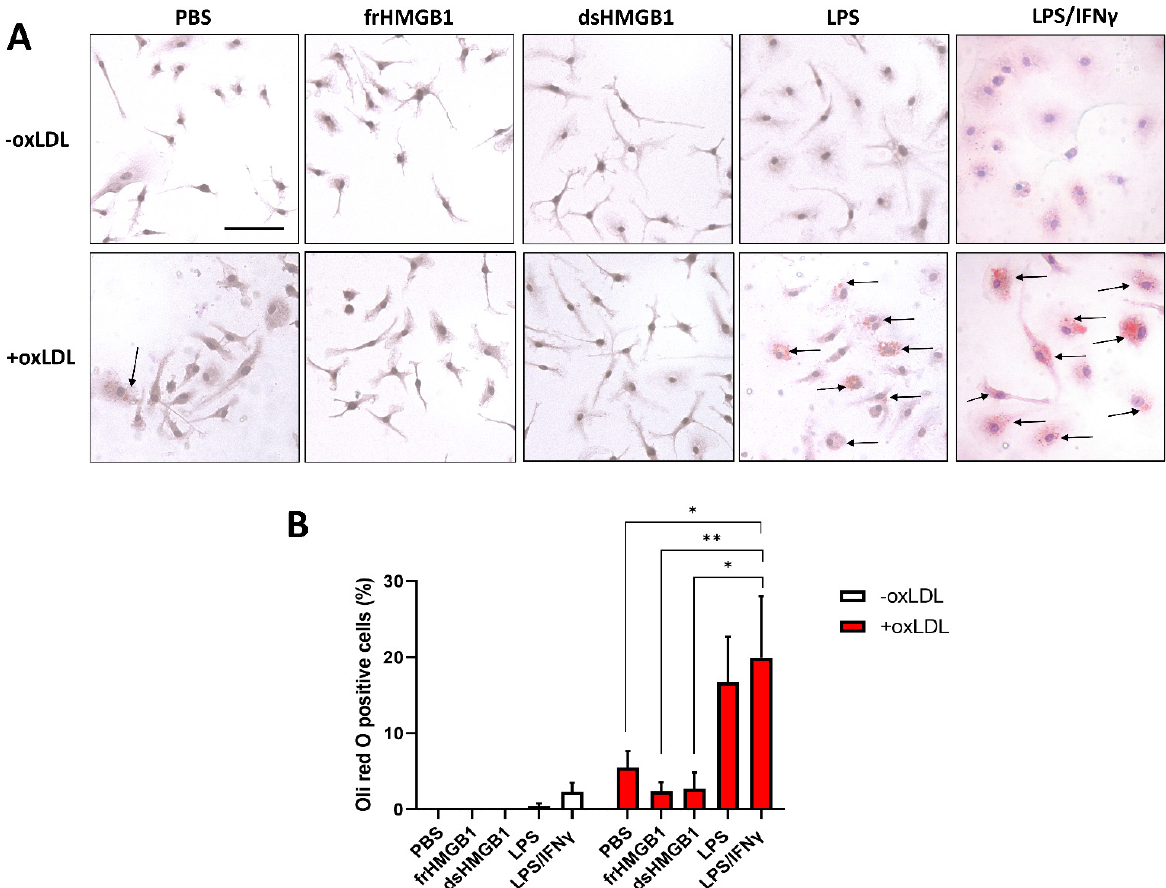
Figure 6. Effects of HMGB1 on foam cell formation from BMDMs. After incubation with frHMGB1 (5 μ g/mL), dsHMGB1 (5 μ g/mL), LPS (1 μ g/mL) or LPS/IFN γ (100 ng/mL LPS and 20 ng/mL IFN γ )